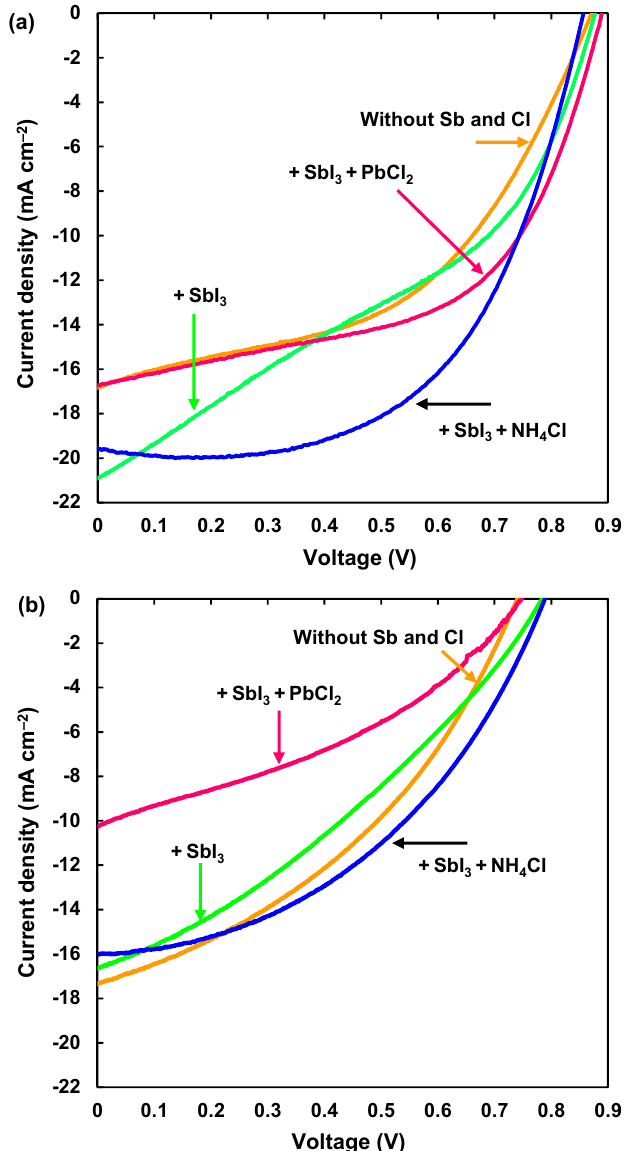
Figure 2. ( a ) J-V characteristic of CH 3 NH 3 Pb(Sb)I 3 (Cl) photovoltaic cells. ( b ) J-V characteristic after 28 days. Table 2. Measured photovoltaic parameters (average and top) of TiO 2 /CH 3 NH 3 Pb(Sb)I 3 (Cl) cells.